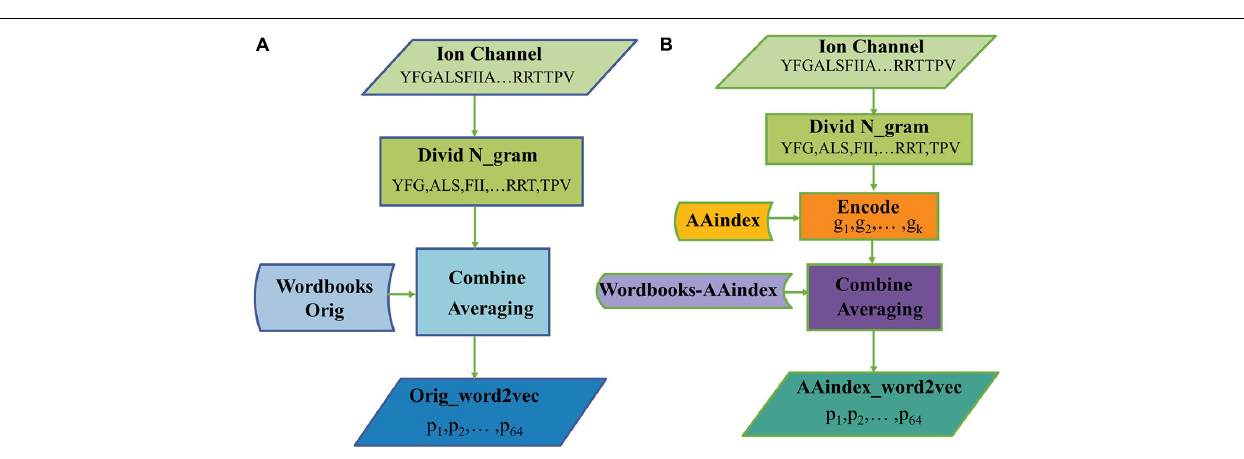
Frontiers in Genetics |